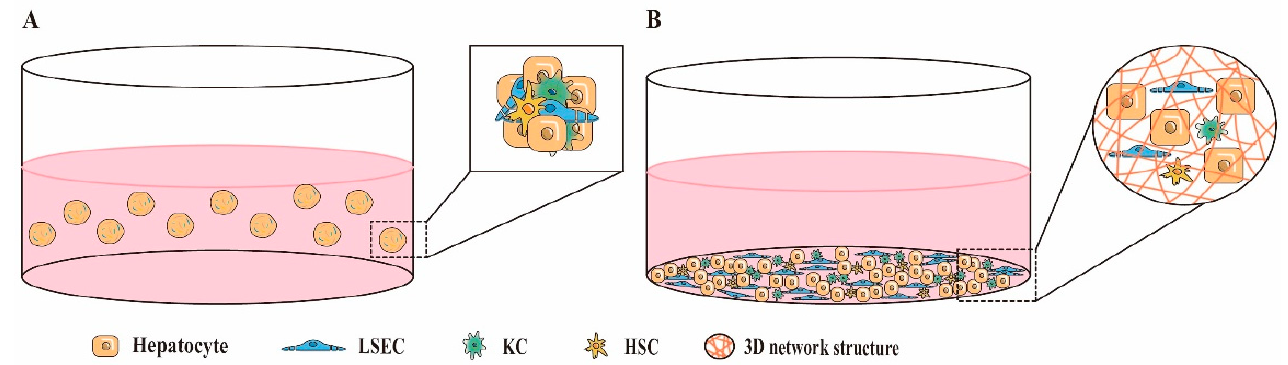
Figure 2. Examples of direct 3D cell co ‐ culture liver models. ( A ) Mixed cell spheroid co ‐ culture system. ( B ) Three ‐ dimensional scaffold co ‐ culture. system. ( B ) Three-dimensional scaffold